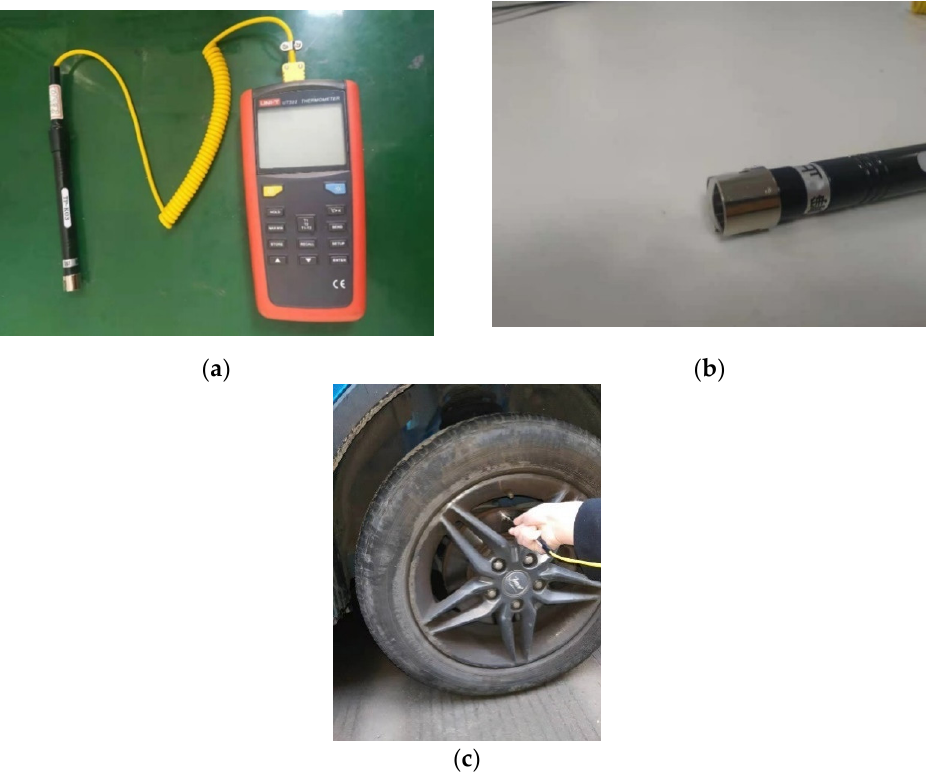
Figure 8. Picture of the contact temperature sensor: ( a ) Picture of the temperature sensor and display instrument; ( b ) Picture of the probe of the temperature sensor; ( c ) Picture of the temperature sensor being used.